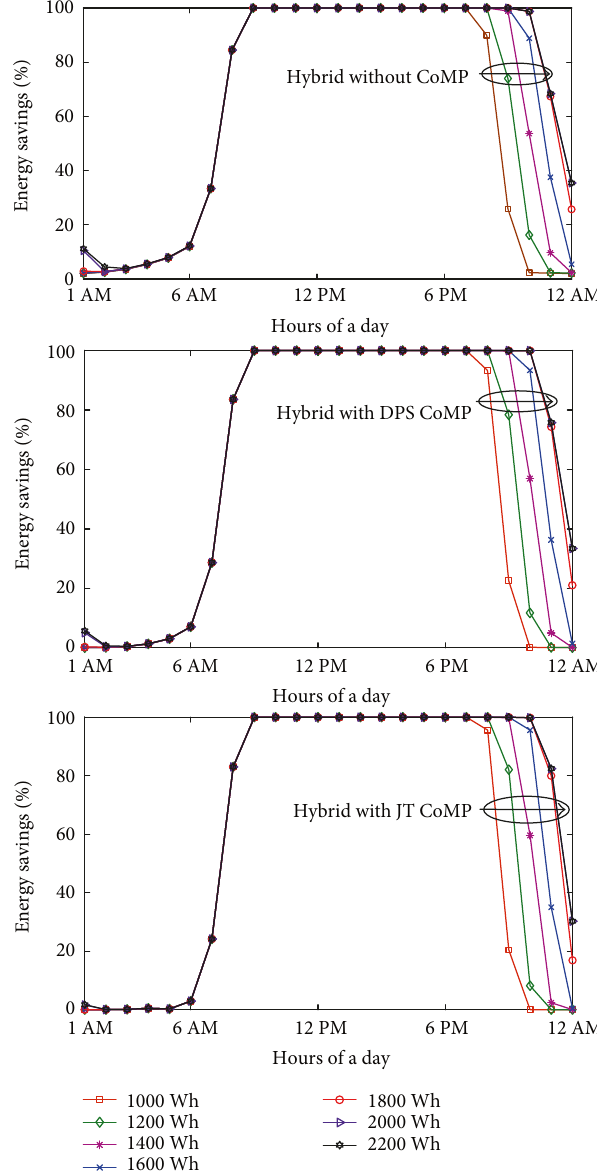
Figure 7: Average on-grid savings of a BS for di ff erent storage capacities with 1kW solar module and no energy